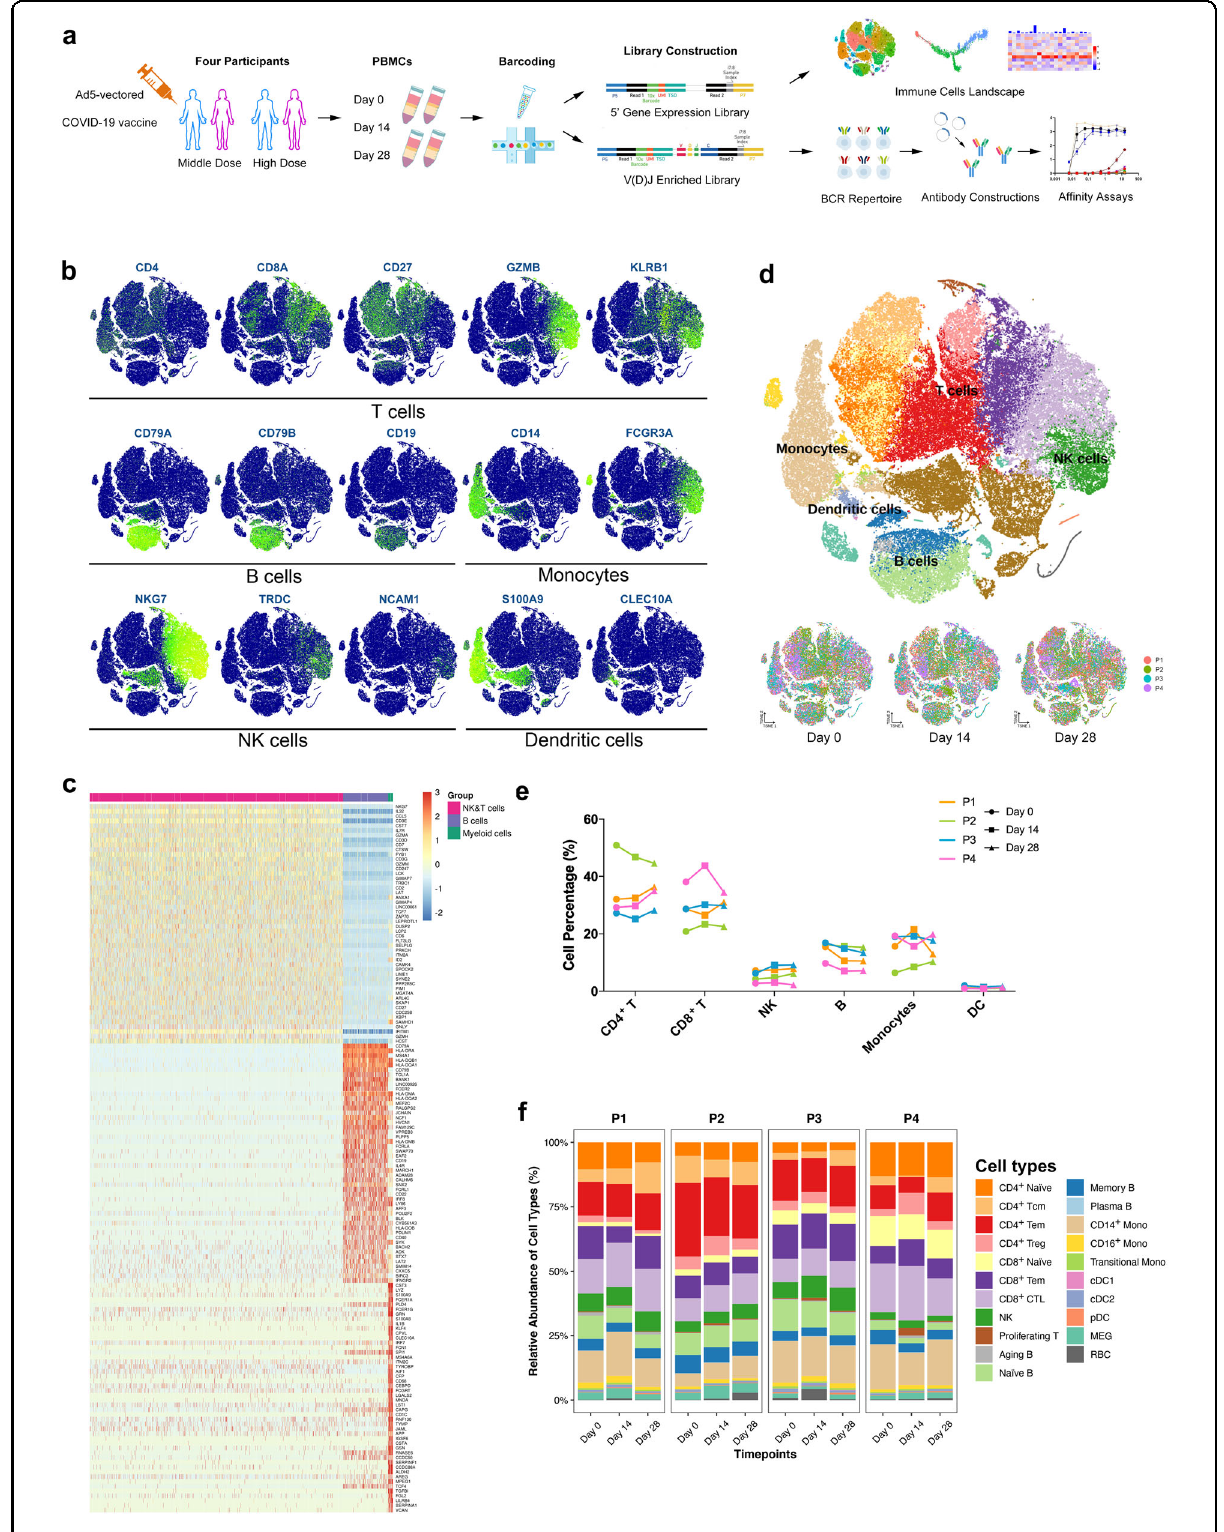
Fig. 1 (See legend on next